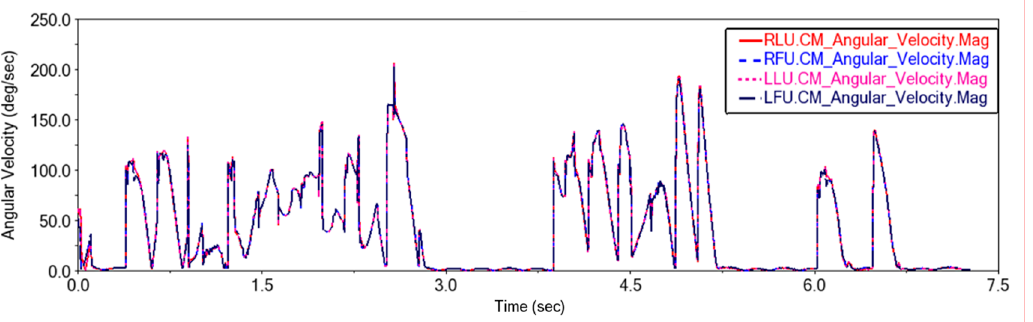
Figure 26. Angular speed comparison curve in Experiment 3. LFU-Front frame upper left joint link, RFU-Front frame upper right joint link, LLU-Rear frame upper left joint link, RLU-Rear frame upper right joint link.